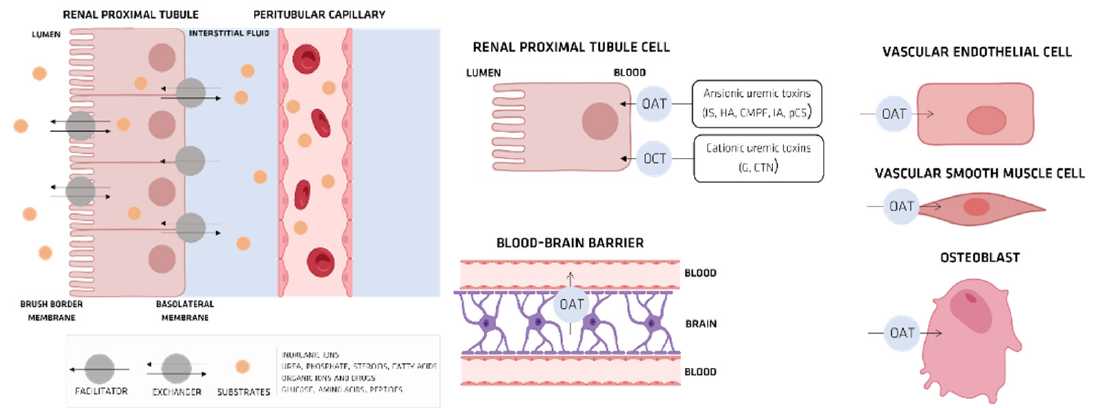
Figure 9. OAT- or OCT-mediated cellular transport of anionic and cationic uremic toxins (adapted from [6]).